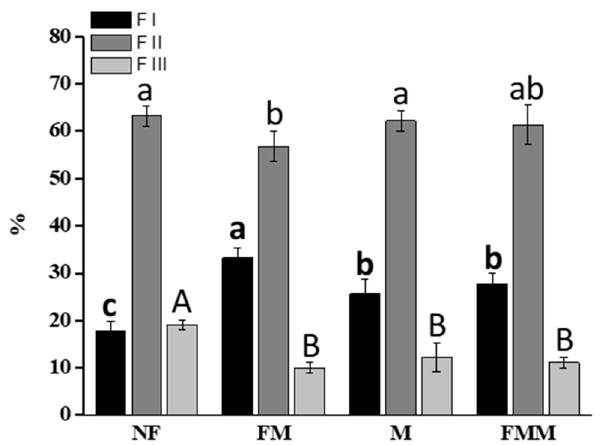
Figure 1. Apparent molecular weight of humic fractions extracted from earthworm coprolites collected in soils fertilized with no inputs (NF), or with manure (FM), mineral fertilizers (M) and with manure plus mineral fertilizers (FMM). FI > 100.000 kDa; FII 10.000–100.000 kDa; FIII < 10.000 kDa. Data represent the means of three measurements. Values above bars following the same letter are not statistically different at p < 0.05 according to Student-Newman-Keuls test. Comparisons were carried out within values of the same HS fraction.